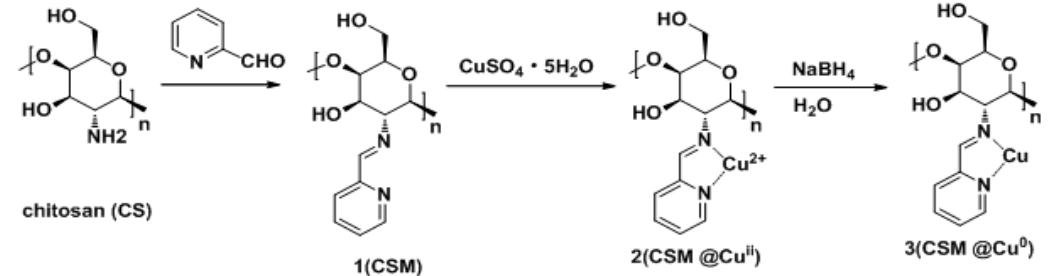
Figure 1. Preparation of chitosan microsphere-supported Cu catalytic materials.